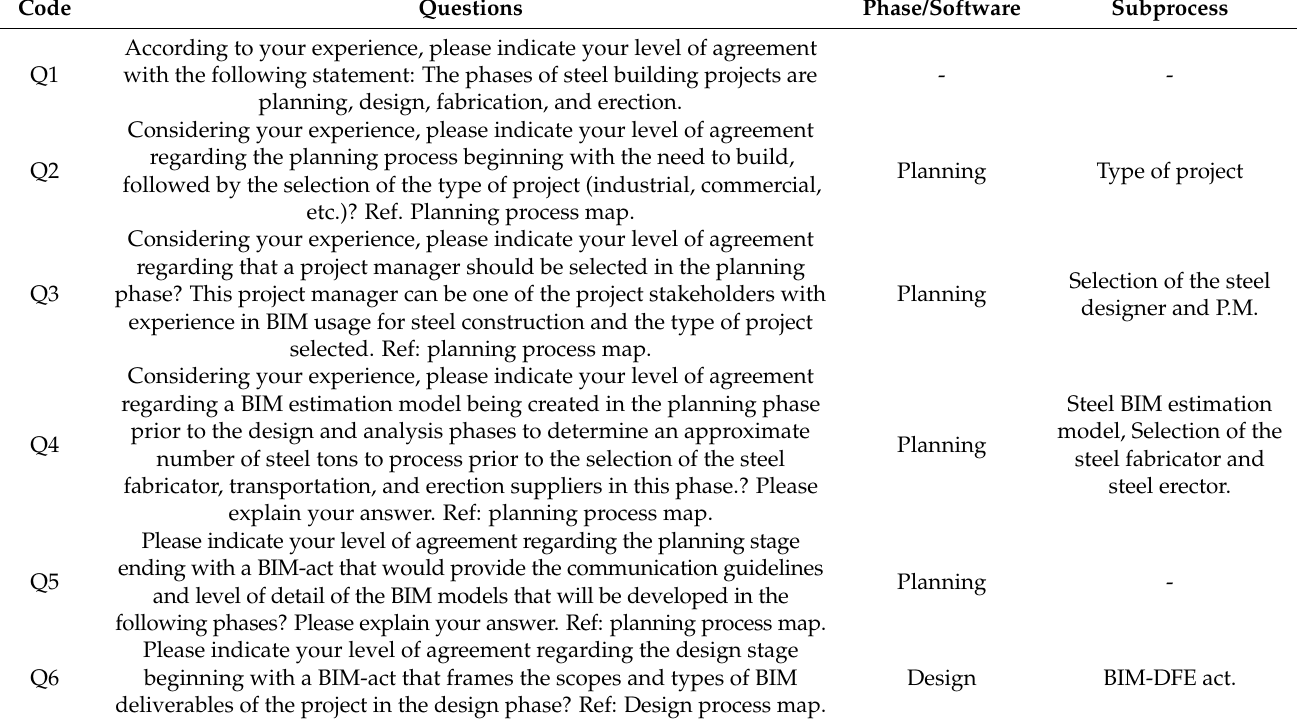
Table A2. Questions for the Second